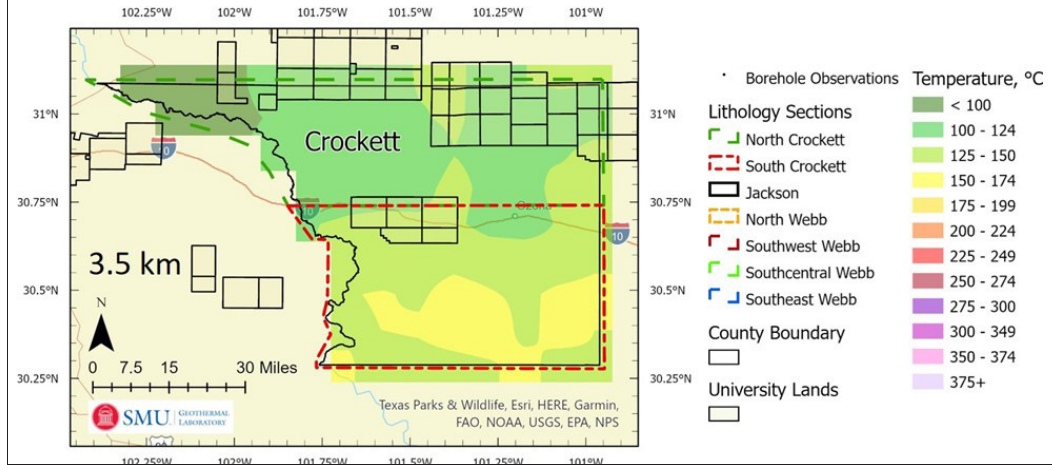
Figure 5. Crockett County temperature at 3.5 kilometers (km; 11,500 feet) depth. The temperature shows a general increase from north and west to south and east. The University Lands are highlighted as boxes on the maps. The dashed lines represent the North and South lithology cross-section areas (Batir and Richards 2020).